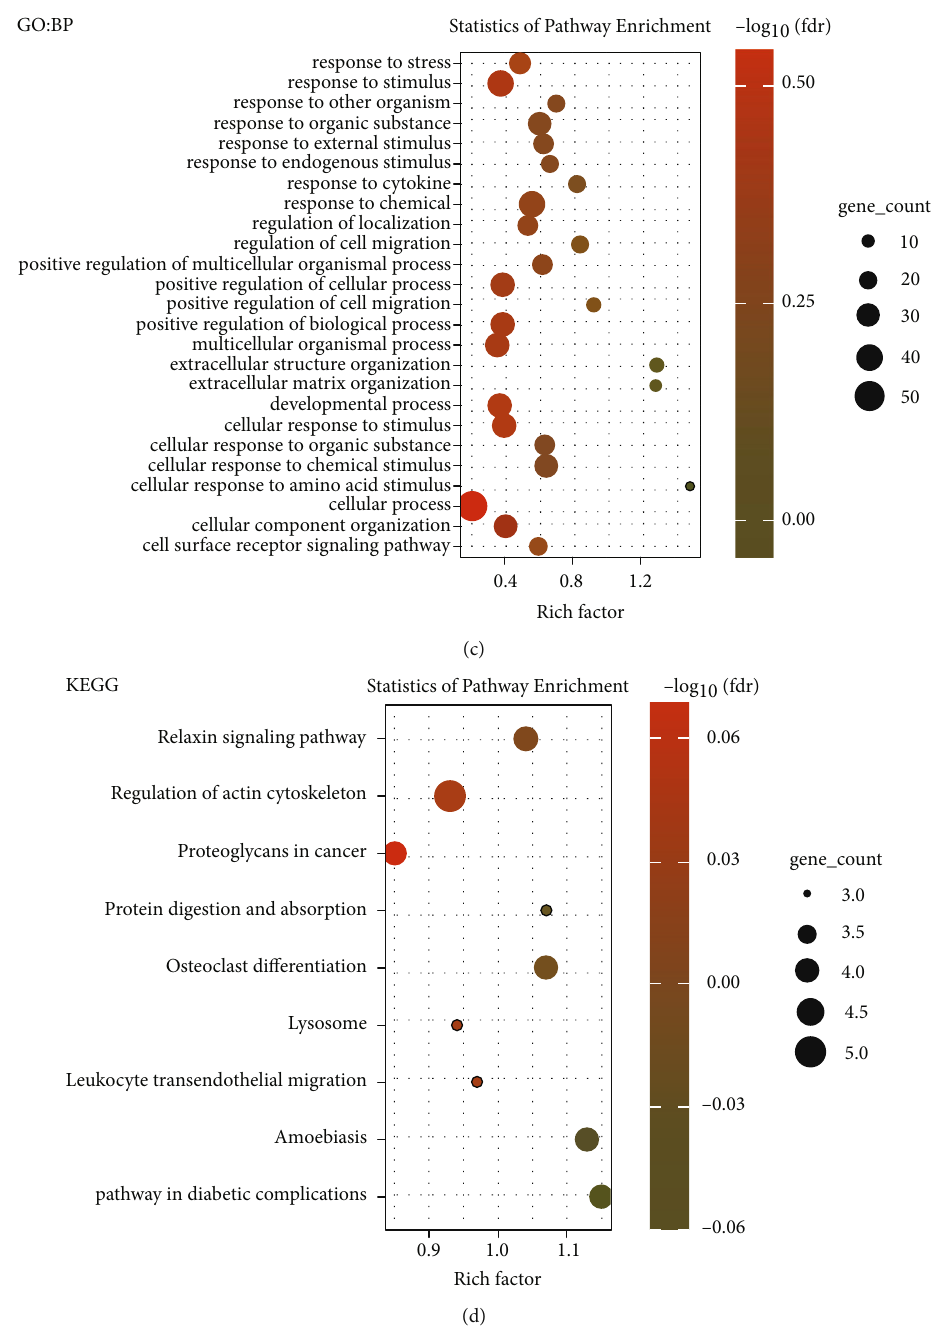
Figure 2: Functional enrichment analysis of DEGs. (a) Bar chart of clustered enrichment ontology categories (including both GO and KEGG terms) by Metascape (colored by P -values; minimum overlap: 3; P < 0 : 01 ; minimum enrichment: 1.5). (b) MCODE enrichment analysis of PPI network by Metascape. Functional enrichment analysis of GO: BP (c) and KEGG (d) using PPI generated by STRING. DEGs were imported into the STRING database to generate a PPI network with a 0.4 minimum necessary interaction score. GO, Gene Ontology; KEGG, Kyoto Encyclopedia of Genes and Genomes; MCODE, Molecular Complex Detection; PPI: protein – protein